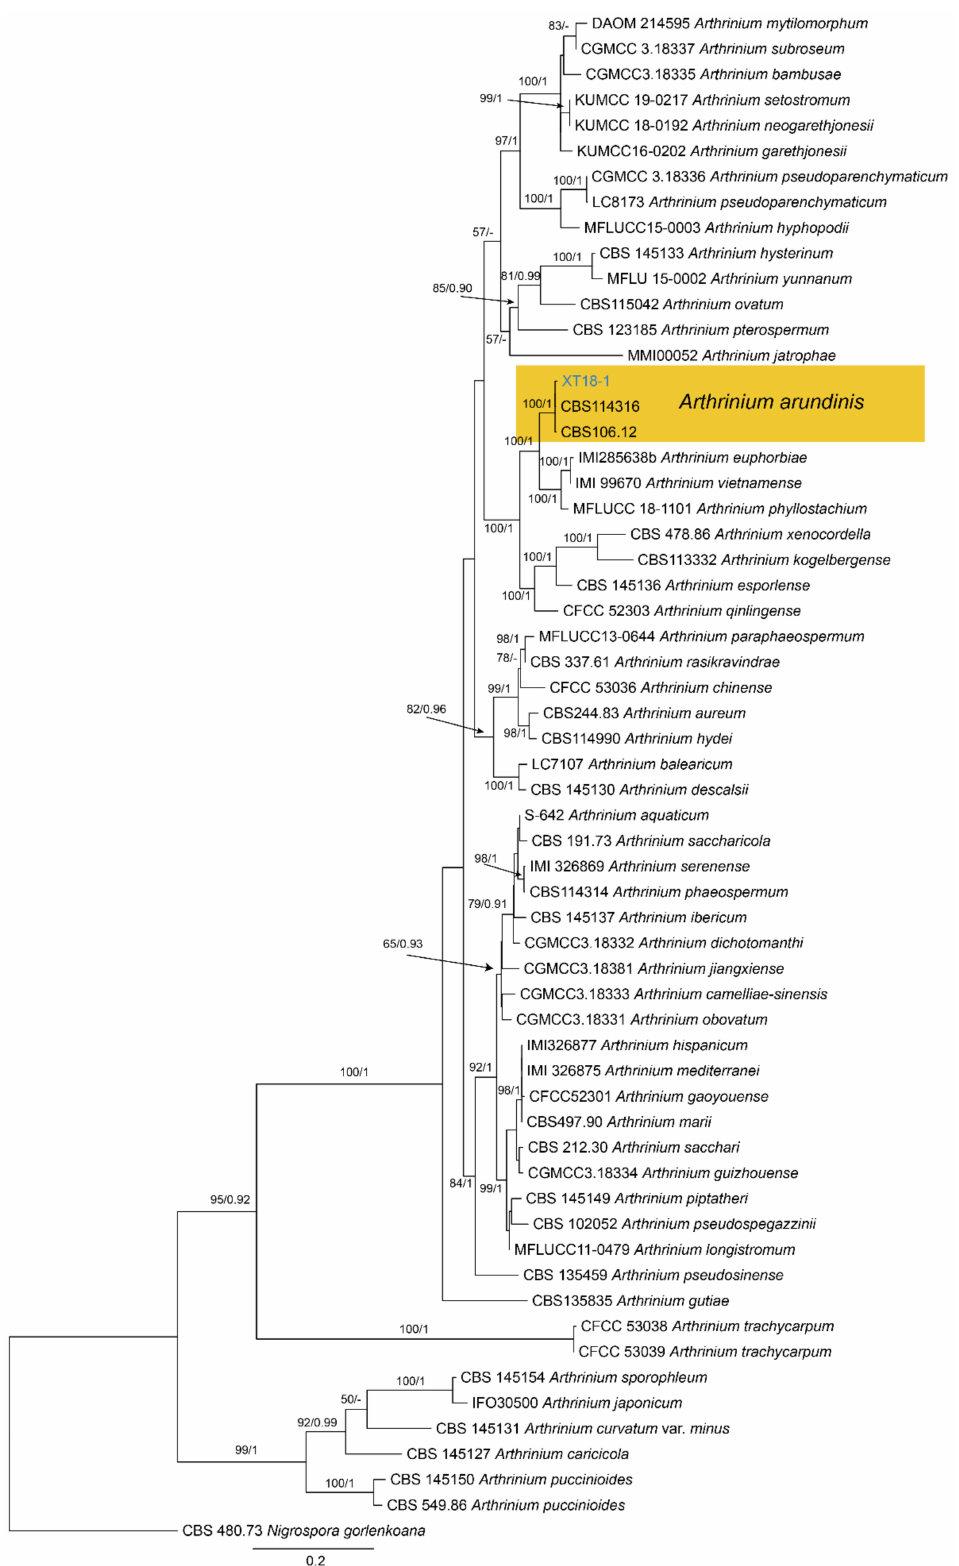
Figure A5. Phylogram generated from RAxML analysis based on combined ITS, tef1 and tub2 sequence data of Arthrinium isolates. The tree was rooted to Nigrospora gorlenkoana (CBS 480.73). The scale bar indicates 0.2 nucleotide changes per site. Isolate from this study is marked in blue, and the identified species is marked in